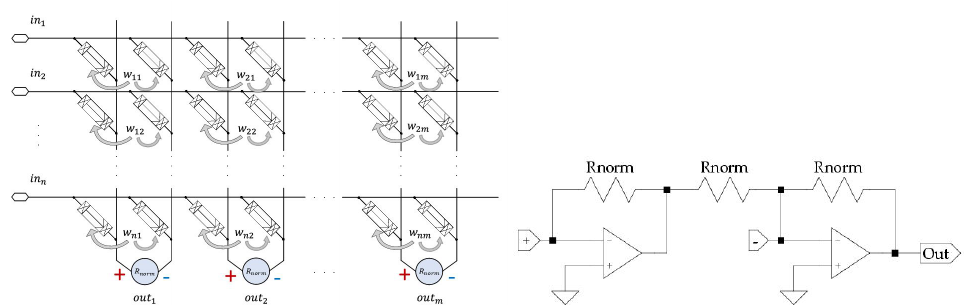
Figure 6. Schematic of a VMM accelerator implementation using two RRAM devices for each synaptic weight in differential fashion ( left ) and of the weighted adder placed at each column ( right